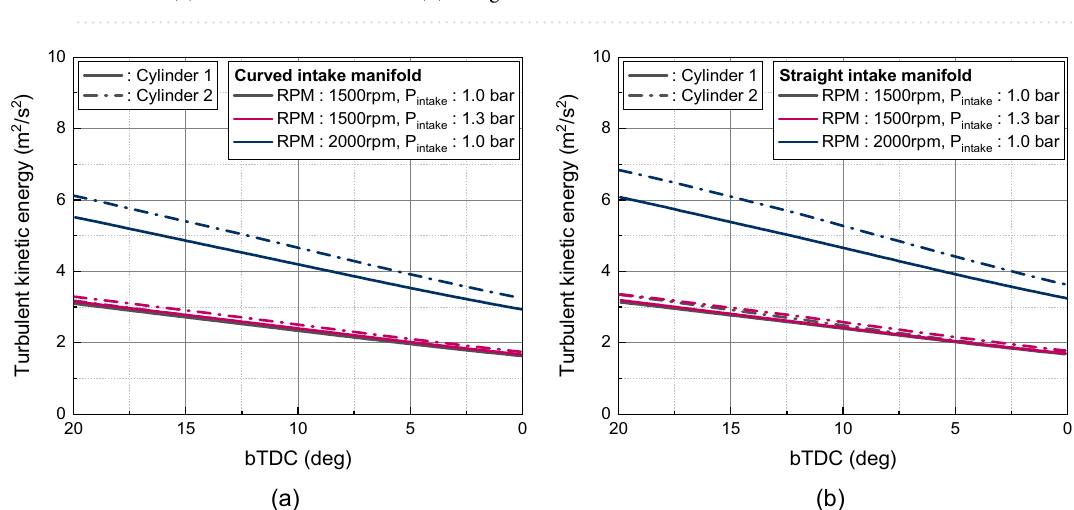
Figure 20. Turbulent kinetic energy near TDC: ( a ) curved manifold, ( b ) straight